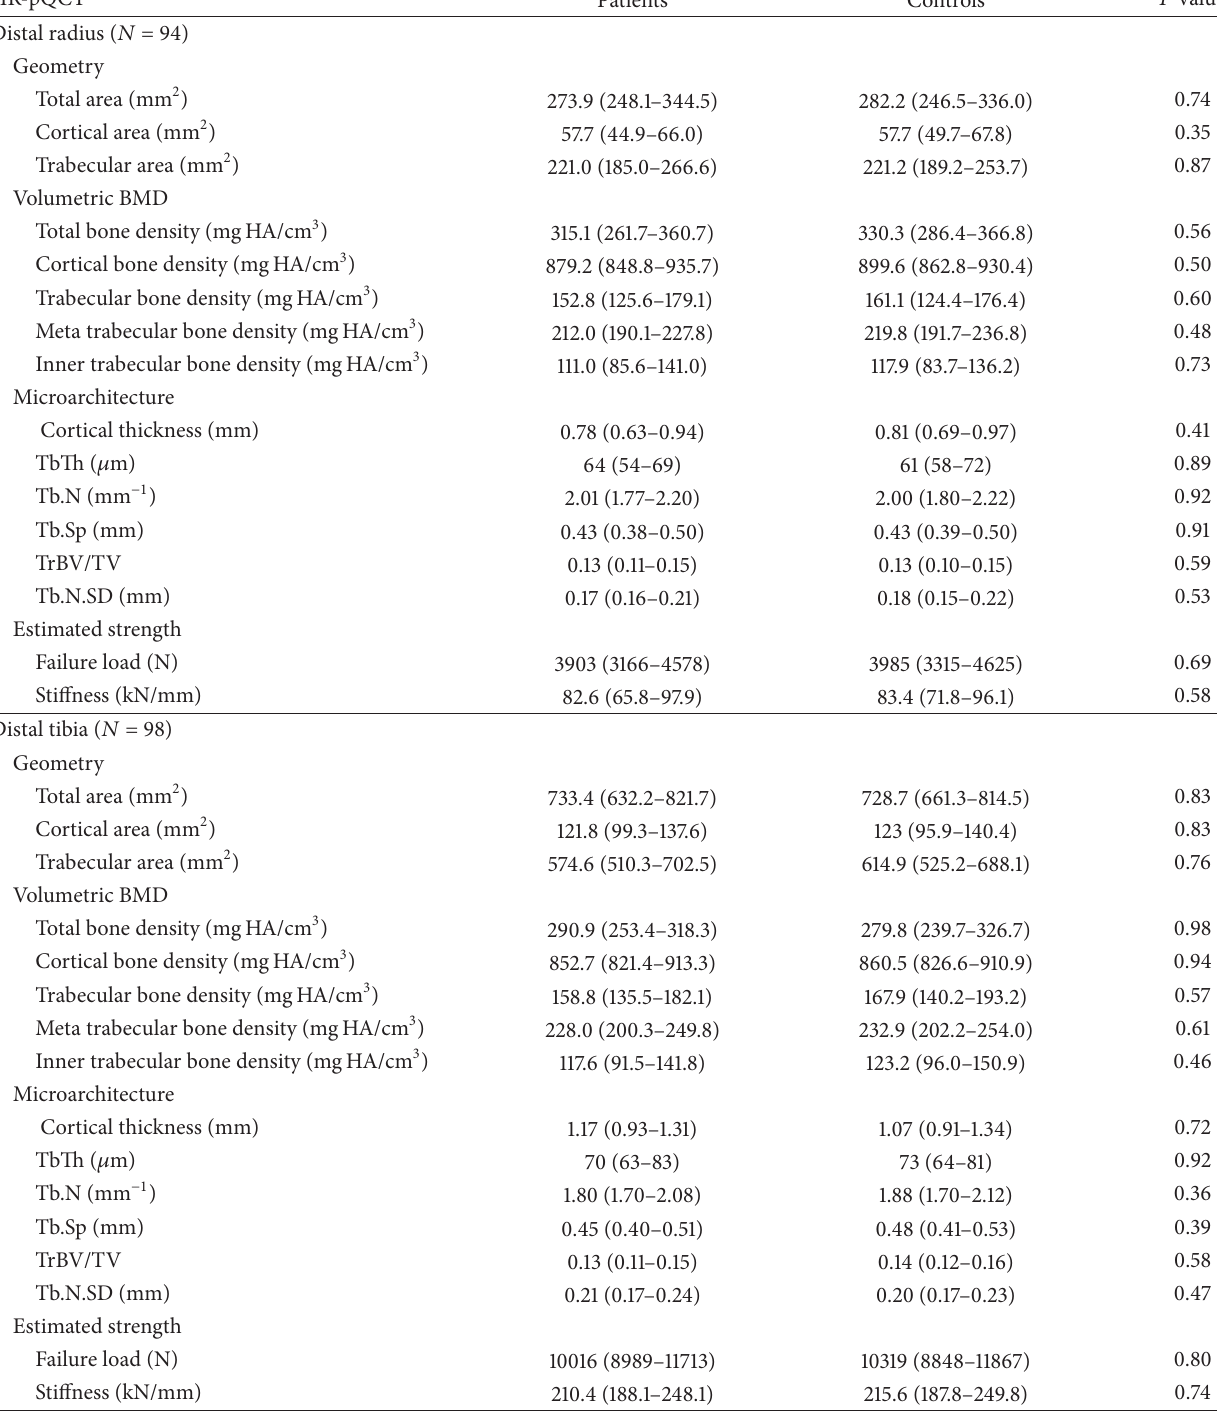
Table 5: Bone indices as measured by HR-pQCT scans in patients on long-term treatment with levothyroxine and matched controls. Median with interquartile (25%–75% percentiles)